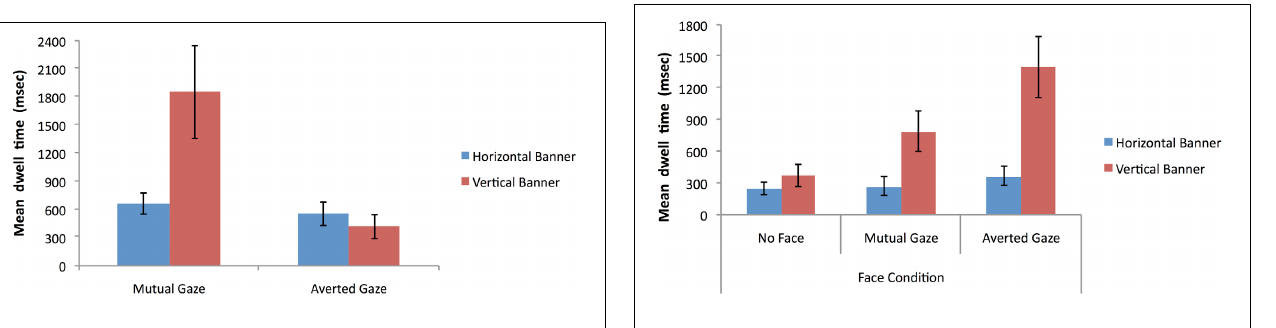
FIGURE 12 | Mean dwell time (milliseconds) on the product ROI for vertical vs. horizontal banner advertisements as a function of face condition (error bars depict the standard error of the